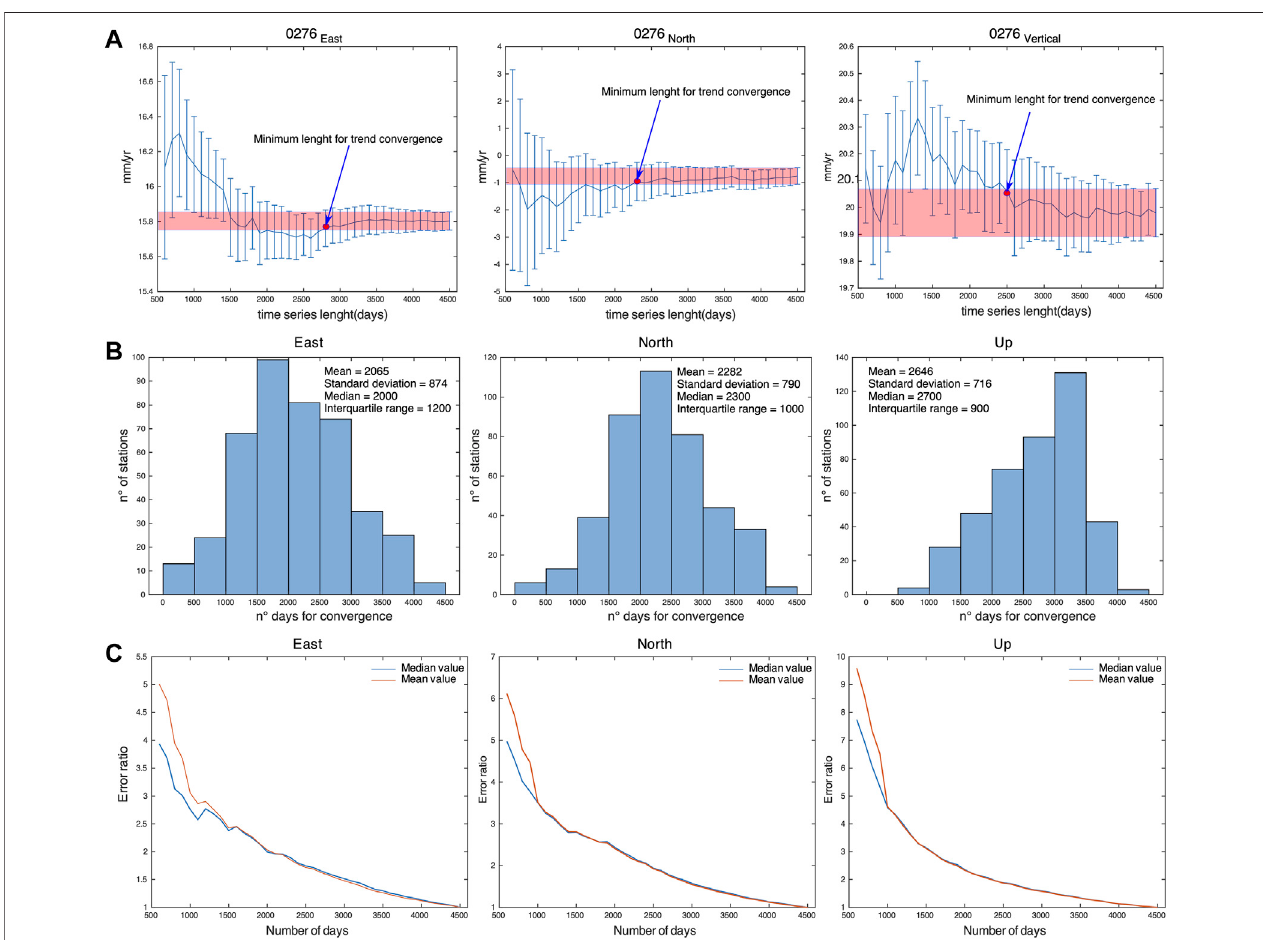
FIGURE 5 | (A) Examples of velocity uncertainty values (2 σ ) for station 0276 (in Germany), estimated for increasing time-spans starting from series length of 2.5 – 12 years(reference value),with 100days timesteps. Theredbandshowsthe95%con fi denceerrorobtained usingthewholetime-seriesandaPL-WNmodel. The red point marks the number of days when the difference between the velocity value and the reference value is smaller than two times the error associated with the reference value. (B) Distribution of the number of days to converge toward the reference velocity values (obtained using the whole, 12 years, time series) at 95% con fi dence level. (C) Mean and median value of the ratio between the error on the velocities estimated with increasing time-series length from an initial time-span of 2.5 years and steps of 100 days, and the error on the velocity estimated using the longest time series.